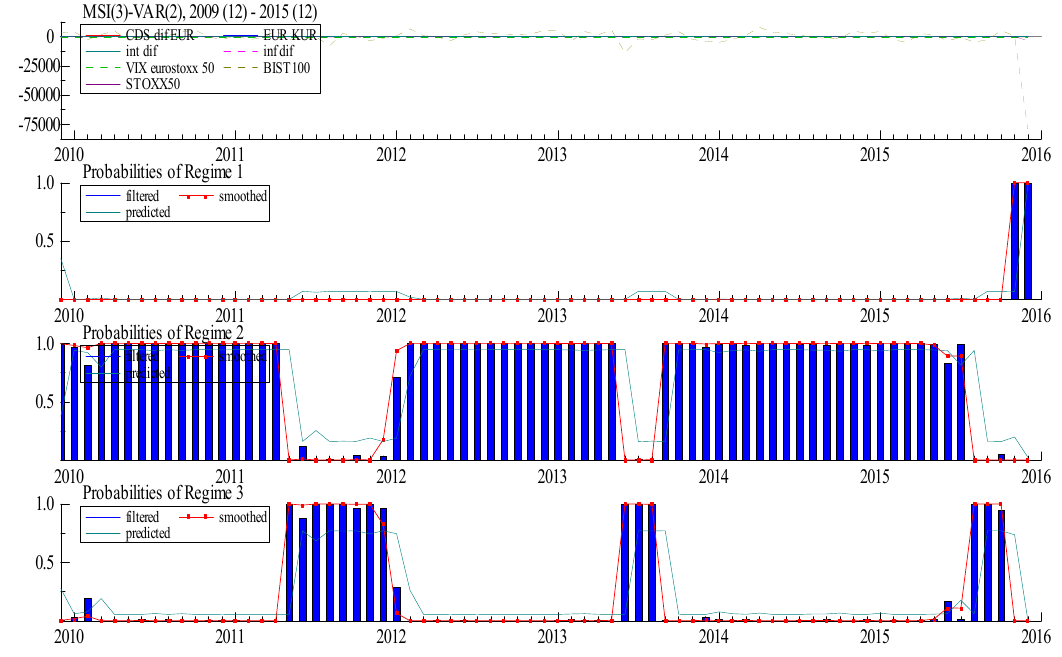
Figure 4. Smoothed avg. posterior probability of regimes 1, 2 and 3.